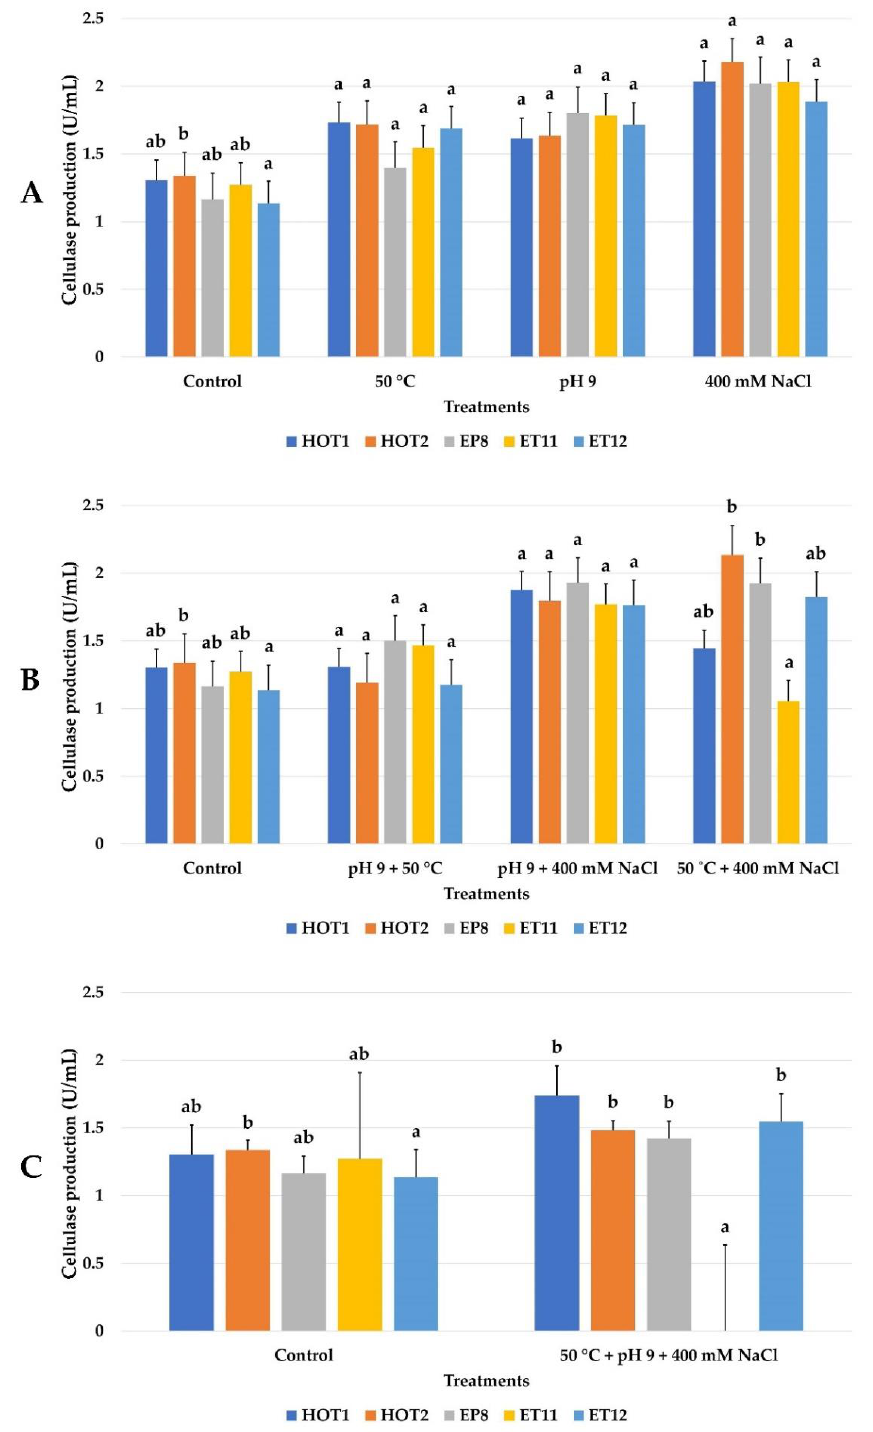
Figure 17. Effect of multiple stresses ( A : temperature ‘50 ◦ C’, pH 9 and 400 mM NaCl separately; B : pH 9 + temperature ‘50 ◦ C’, pH 9 + 400 mM NaCl and temperature ‘50 ◦ C’ + 400 mM NaCl; C : temperature ‘50 ◦ C’+ pH 9 + 400 mM NaCl) on cellulase production in liquid medium. The results are expressed as the mean-standard error of the values of the enzymatic unit in duplicate. The effects of the stresses corresponding to each treatment and not sharing the same letters are significantly different according to Tukey’s post hoc HSD